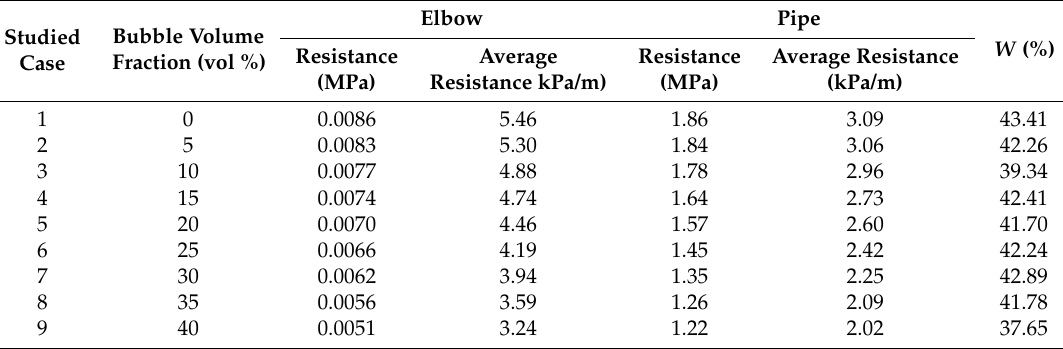
Table 5. Comparison between the pressures in the pipeline and the elbow.